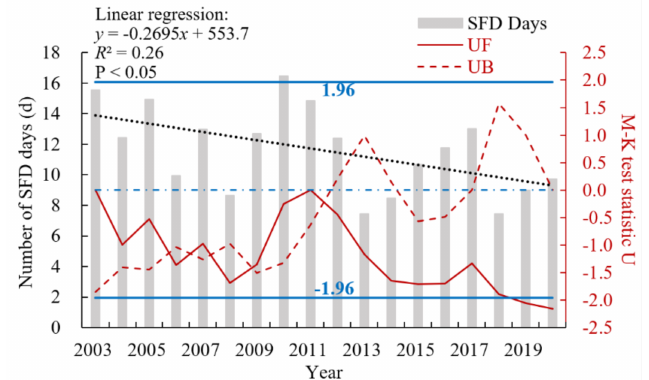
Figure 3. Annual dynamics of SFD days derived from the satellite data for tea plants and the sequential Mann-Kendall (M-K) test results during 2003–2020. The gray histogram and black dotted line are annual SFD days and its linear regression (left y -axis), respectively. The solid and dashed dark red lines are the M-K test statistics (right y -axis) for forward ( UF ) and backward ( UB ). The dash-dotted blue line is statistic value 0, and the solid horizontal dark blue lines represent the upper and lower limits of the 95% confidence